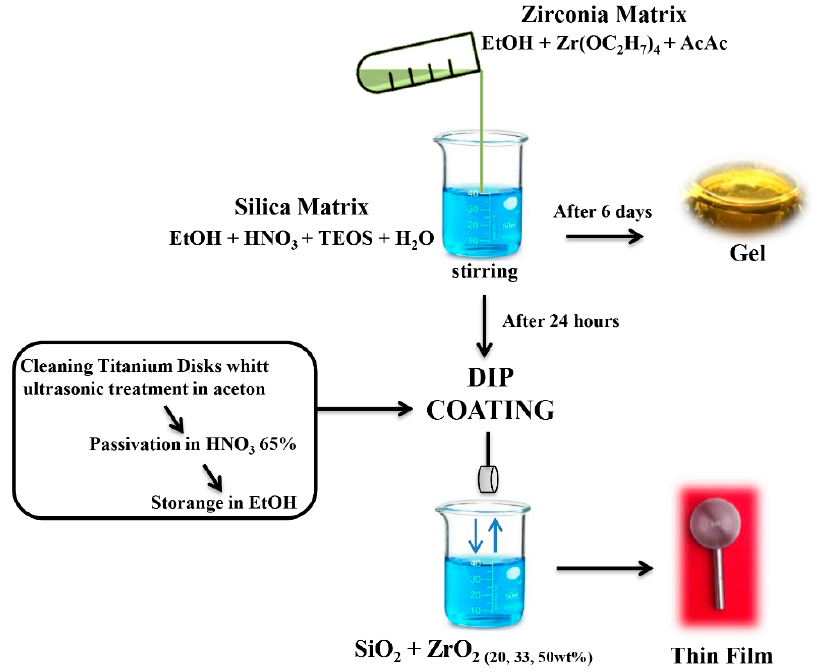
Figure 1. Flow chart of the Figure 1 . Flow chart of the process .